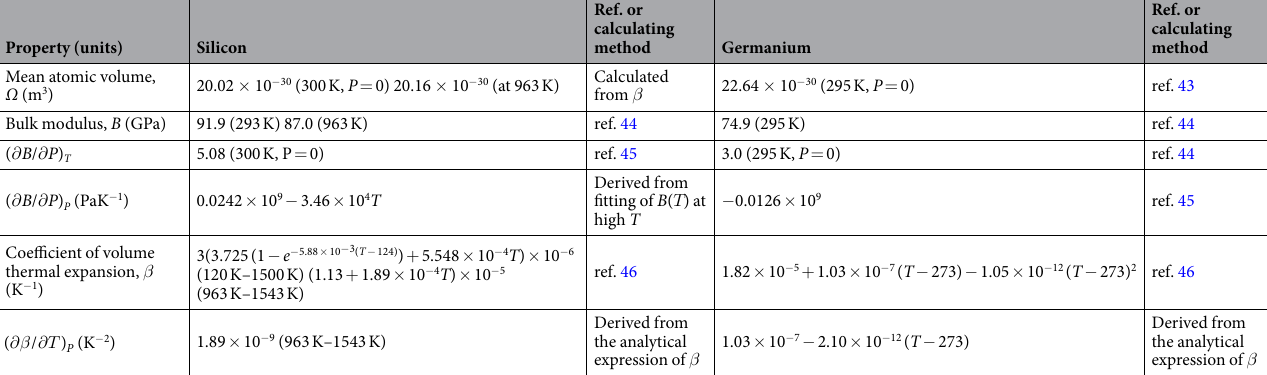
Table 1. List of necessary properties of the two end members (Si and Ge) for the proper implementation of the cBΩ model in Si 1 − x Ge x alloys at different Ge